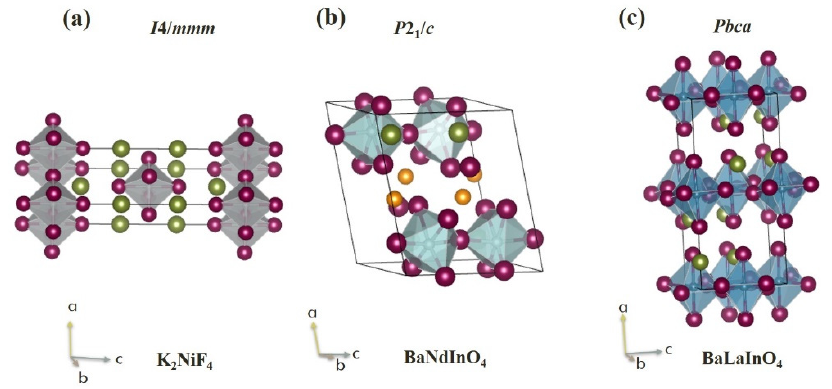
Figure 1. Structure of K 2 NiF 4 ( a ), BaNdInO 4 ( b ), and BaLaInO 4 ( c ), where red spheres represent the oxygen atoms, green spheres represent the atoms of A-sublattice (K/Ba/La), and orange spheres represent the neodymium atoms.